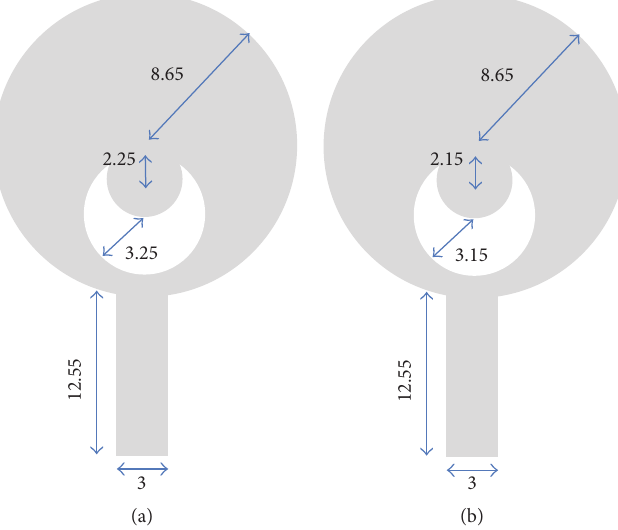
Figure 10: Geometry of the UWB antenna. (a) Preliminary design and (b) final design.